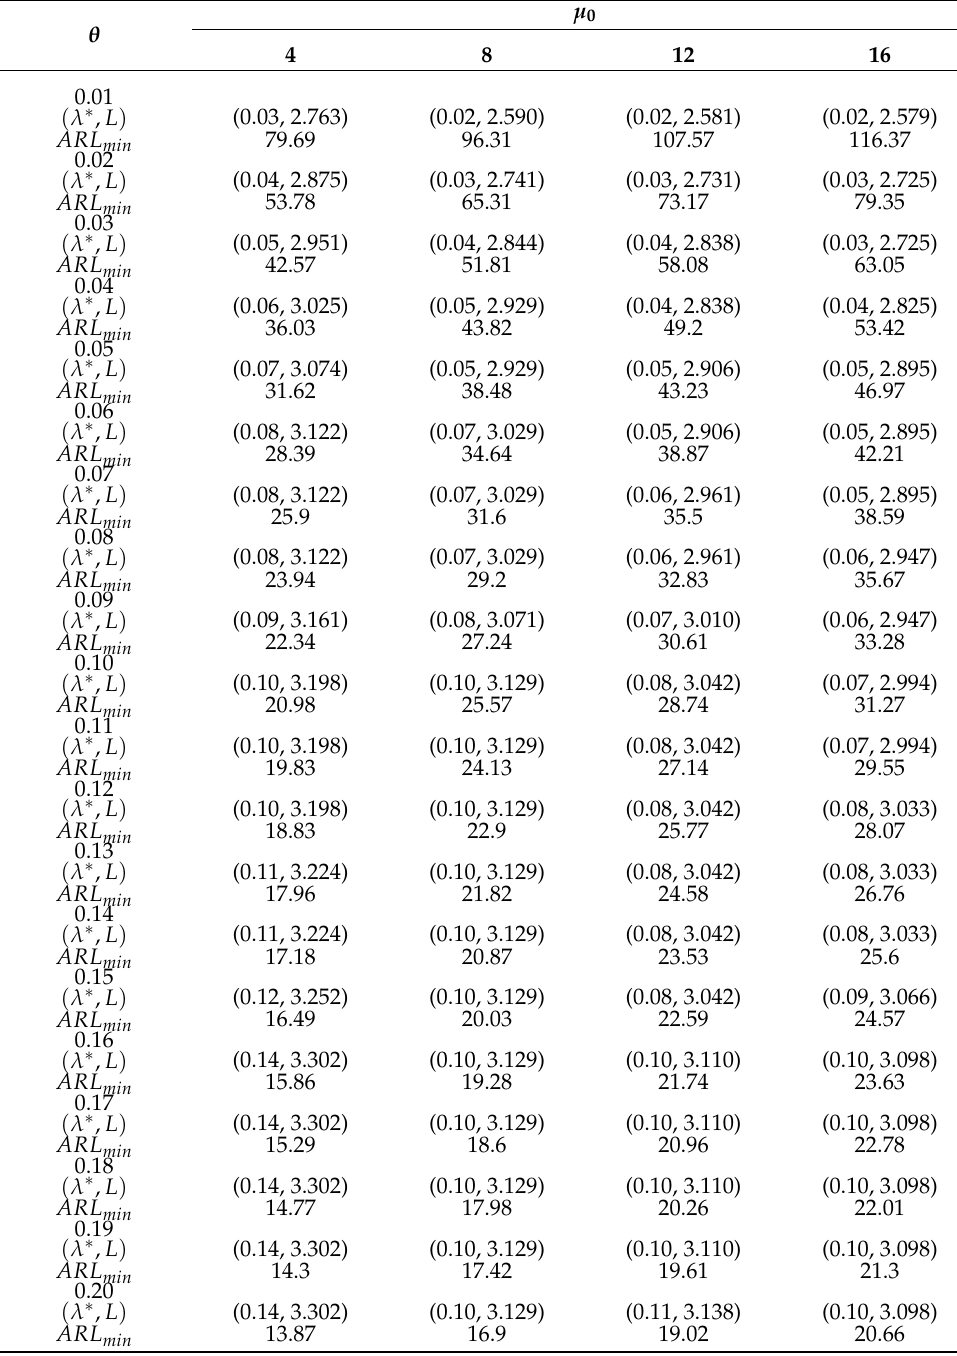
Table 6. Optimal parameters for the EWMA chart when ARL 0 =